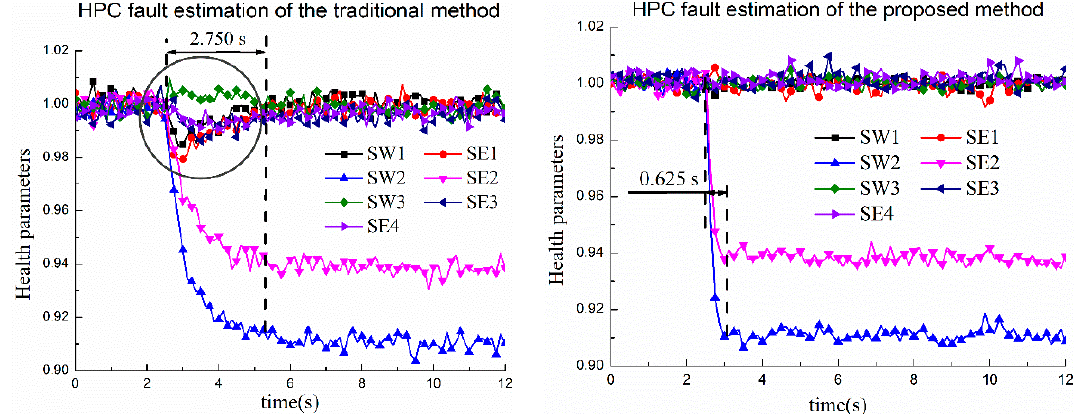
Figure 11. The comparison of the traditional and the proposed methods in Case 1.